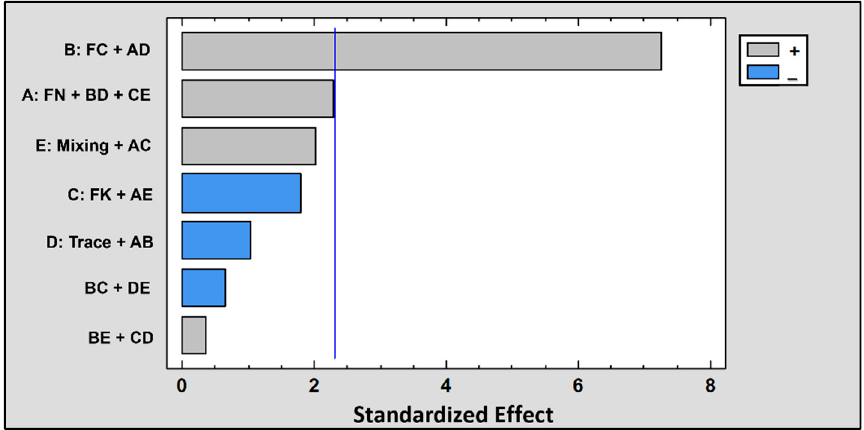
Figure 3. Pareto diagram for bioleaching of gold using infrared spectrum absorbance at 1456 cm − 1 .